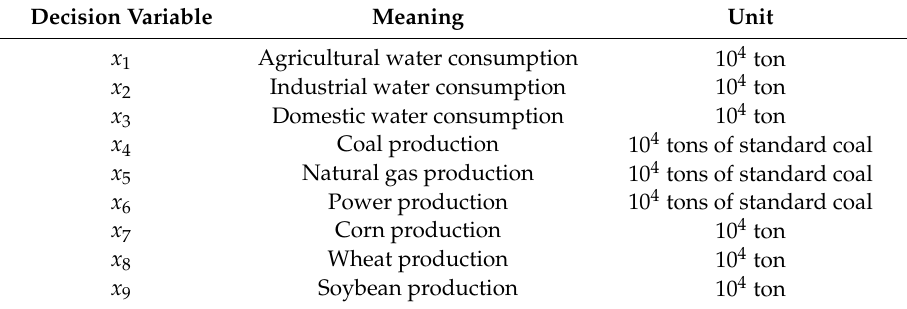
Table 1. The meaning and unit of each decision variable of the multi-objective programming model of a regional water–energy–food